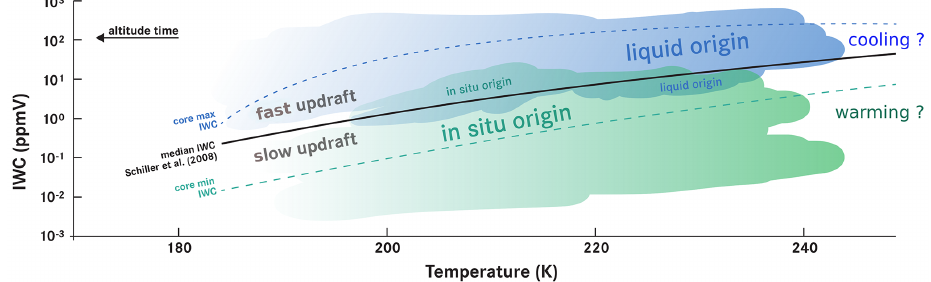
Figure 13. Sketch of in situ and liquid origin cirrus (large letters: high frequency of occurrence, larger ice crystals, stronger sedimentation, longer lifetimes; small letters: low frequency of occurrence, smaller ice crystals, lesser sedimentation, shorter lifetimes). In situ origin cirrus (greenish color): ice crystals form heterogeneously+homogeneously directly from the gas phase. In situ cirrus are preferably thin with lower IWC. They divide in two classes (see also Fig. 9): (1) thin cirrus forming in slow updrafts consisting of few, large ice crystals with a large geographic coverage and a long lifetime, (2) thicker cirrus forming in fast updrafts consisting of many, small ice crystals with a smaller geographic coverage. Liquid origin cirrus (blueish color): ice crystals stem from frozen liquid drops which are uplifted from farther below in the atmosphere into the cirrus temperature range. Liquid origin cirrus are mostly thick with higher IWC and have larger ice crystals than the in situ cirrus (for more detail see Luebke et al., 2015). Their geographic coverage and lifetime depend on the meteorological situation: larger and longer in warm conveyor belts, smaller and shorter in convective